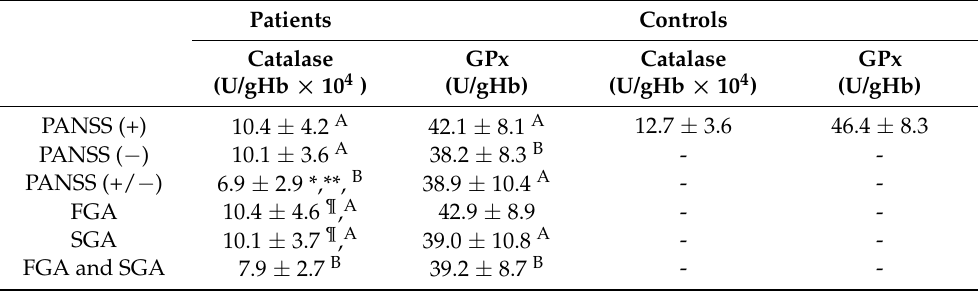
Table 3. Erythrocyte catalase and GPx activities in patients with schizophrenia related to the predom- inant symptomatology and drug